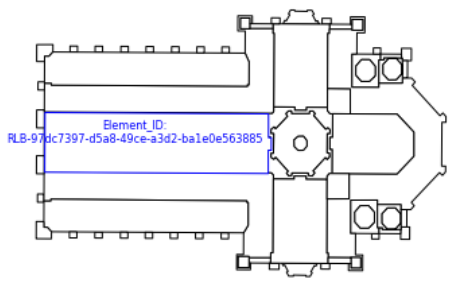
Figure 5. In blue an example of Element ID of a component of Milan’s Cathedral.